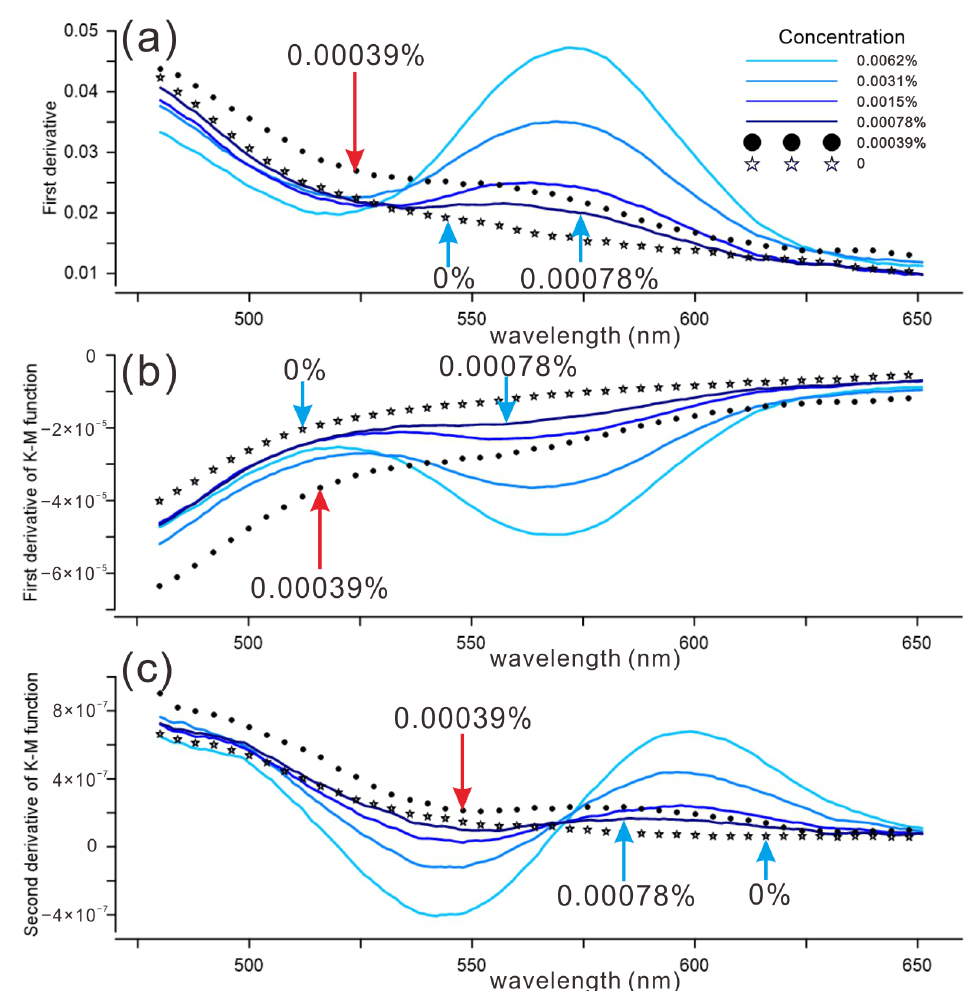
Figure 4. Technical level of lower limit for processing methods: ( a ) first derivative, ( b ) first derivative of the K–M function, and ( c ) second derivative of the K–M function.